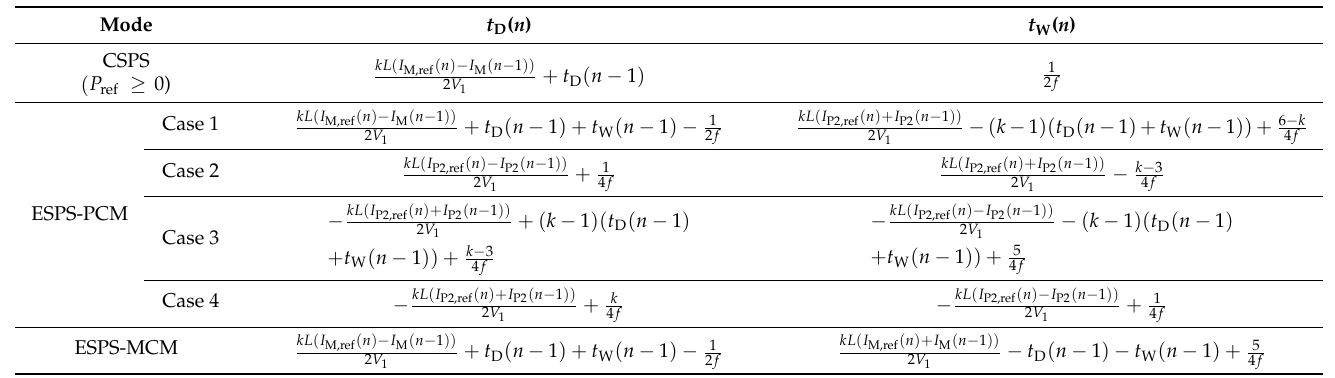
Table 1. Control variable calculation with one-cycle delay